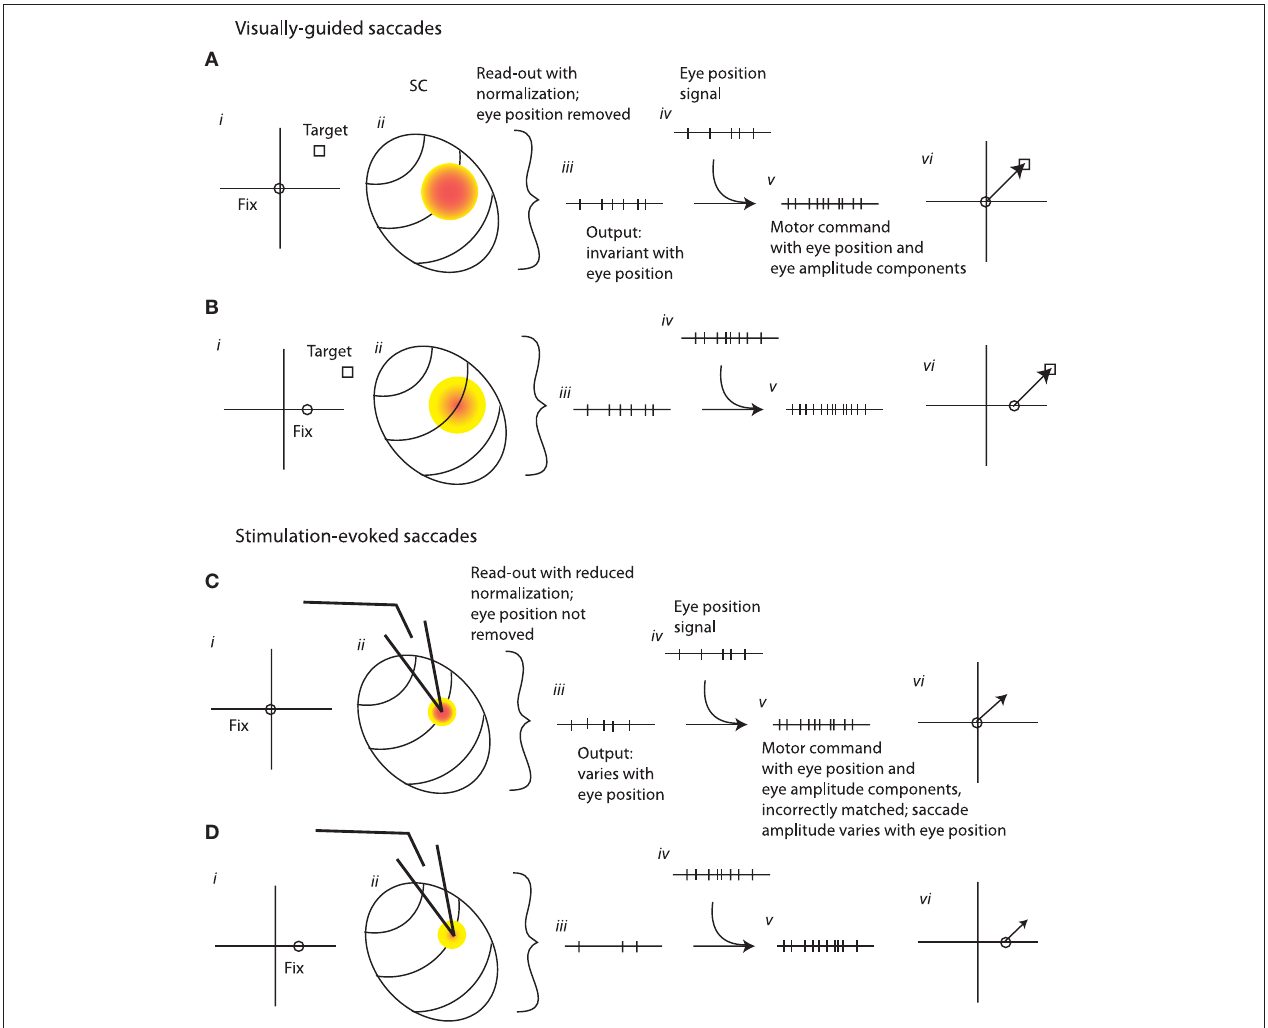
generating an accurate saccade to the target (vi) . (C,D) . How this circuit would have to operate in order to account for the eye position dependence of stimulation-evoked saccades.Stimulation evokes activity at the same site in the SC regardless of initial fixation, but the stimulation combines with endogenous eye position signals to produce a hill of activity that varies in level. The stimulation-evoked activity is too weak to trigger normalization, so the output is lower and is not invariant across eye positions [different numbers of spikes in (Ciii) and (Diii) ; and fewer spikes than the corresponding (Aiii) and (Biii) ]. The motor command that is generated does not have the correct number of spikes to bring the eyes all the way to the (non-existent) target (Cv and Dv) , and the saccades fall short by amounts that depend on eye position (Cvi and Dvi